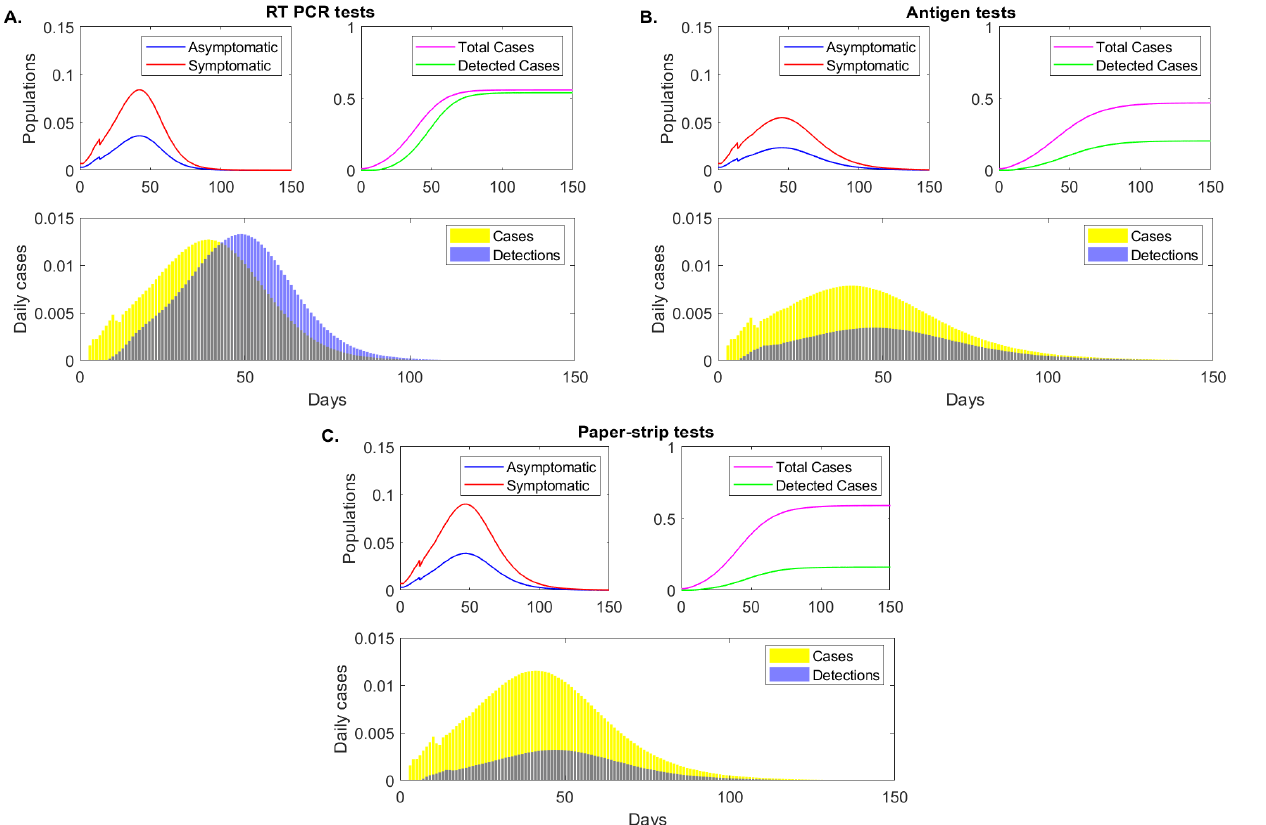
Figure 2. Epidemic dynamics over time . Sample epidemic dynamics results from varying testing regimes, as given by ( V ) = 2, test return delay model Equation (5) for fixed testing capacity. Panel ( A ): RT-PCR, detection threshold log 10 ( V ) = 5, test return delay 0.5 days; Panel ( C ): paper-strip test, 5 days; Panel ( B ): antigen test, detection threshold log 10 ( V ) = 6, test return delay 0.1 days. Upper left figures: asymptomatic (blue), symptomatic (red) case detection threshold log 10 (as proportion of the total population) over time. Upper right figures: cumulative positive cases (magenta) and cumulative detected cases (green) (as proportion of the total population) over time. Lower figures: daily new cases (yellow bars) and daily new case detections (blue